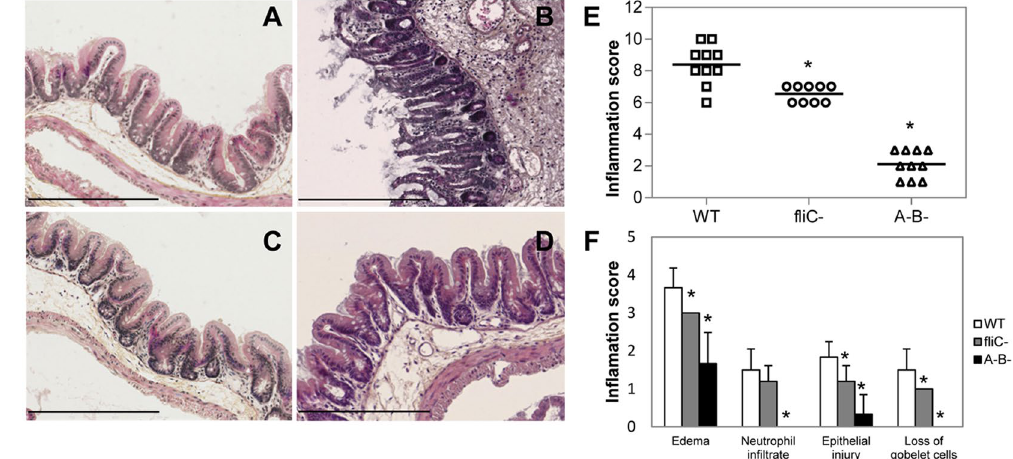
Figure 2. C. difficile 630 Δ erm flagella are involved in caecal inflammation of mice. C57BL/6 mice (n = 10) were infected by oral gavage or not and caeca were collected at the clinical end point day 2 for histology. ( A ) Representative histology of caecum of healthy uninfected mice (control) with epithelium integrity; ( B ) 630 Δ erm WT-infected mice with moderate desquamation, exudates and necrotic cells in the intestinal lumen, edema, and inflammatory submucosa cell infiltration; ( C ) fliC and ( D ) A − B − mutant-infected mice with normal mucosa (200X magnification). Bar = 200 µ m. ( E ) Inflammation histological scores for individual mice in each group. The horizontal lines represent the mean scores for each group of animals. ( F ) Individual evaluation criteria of intestinal inflammation. The bars represent the mean scores for each group of animals and standard deviations. * P < 0.01 compared to WT-infected mice.